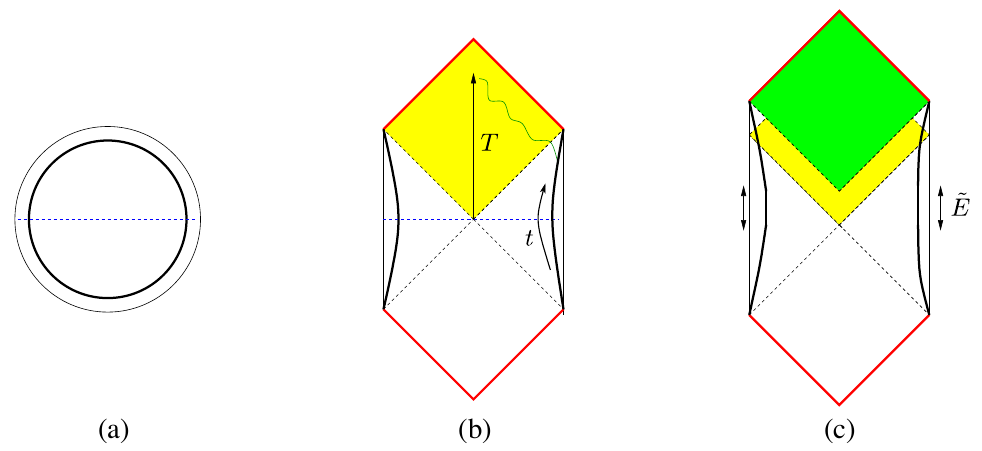
Figure 10 . (a) The standard Euclidean AdS 2 picture and its continuation to Lorentzian signature (b). This looks similar to the vacuum decays to AdS studied by Coleman and de Luccia [34]. They have shown that the addition of irrelvant operators at the domain wall, which is the boundary for us, leads to a divergence in the bulk at the red line. A bulk observer moving along the central black arrow gets to see a lot of the boundary in a very small proper time. This is the usual blue-shift near the inner horizon. In (c) we evolve for some time using the generator ~ E . This allows us to explore some of the region that was behind the horizon, but the new horizon moves up. The yellow region was behind the horizon and now it is